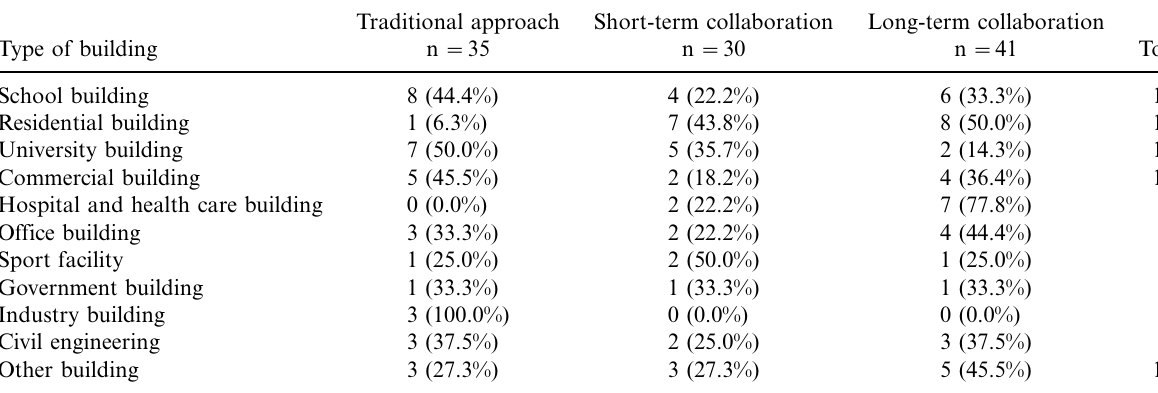
Table 1. Application of supply chain collaboration by sectors